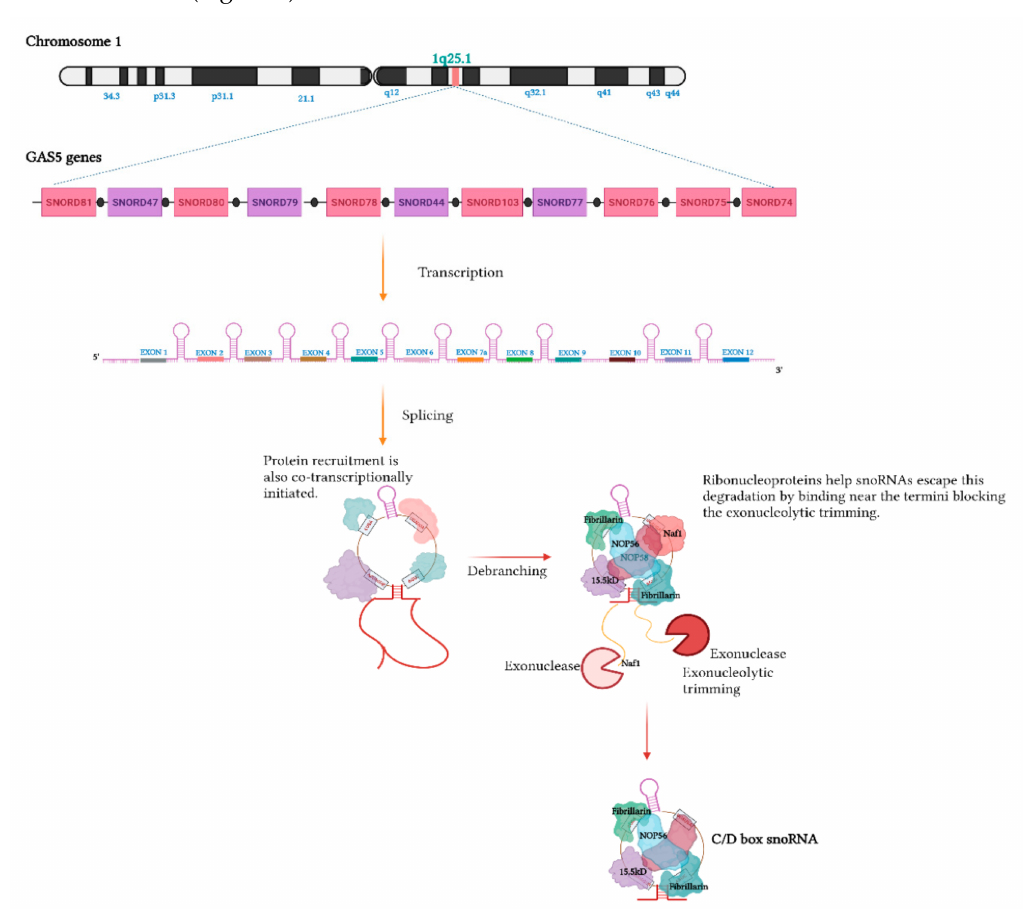
Figure 3. Encoding of multiple snoRNAs within a single non-coding transcript: Eleven intronically derived C/D box snoRNAs are produced from the growth arrest-specific 5 gene, GAS5 . snoRNP assembly is initiated co-transcriptionally with snoRNP-associated proteins (15.5 kD, fibrillarin, NOP58, and NOP56) and auxiliary factors (Naf1, Shq1), protecting the snoRNAs from exonuclease trimming. The GAS5 transcript contains snoRNAs separated by exons; these exons in GAS5 do not code for any protein 64. This transcription style in humans is different than the polycistronic transcription observed in yeast 65. Additionally, the open reading frame for GAS5 transcript, not being required for protein production, is poorly conserved across species. However, a striking conservation exists across species for intronically encoded snoRNAs. Taken together, this suggests biologically significant roles for GAS5 -encoded